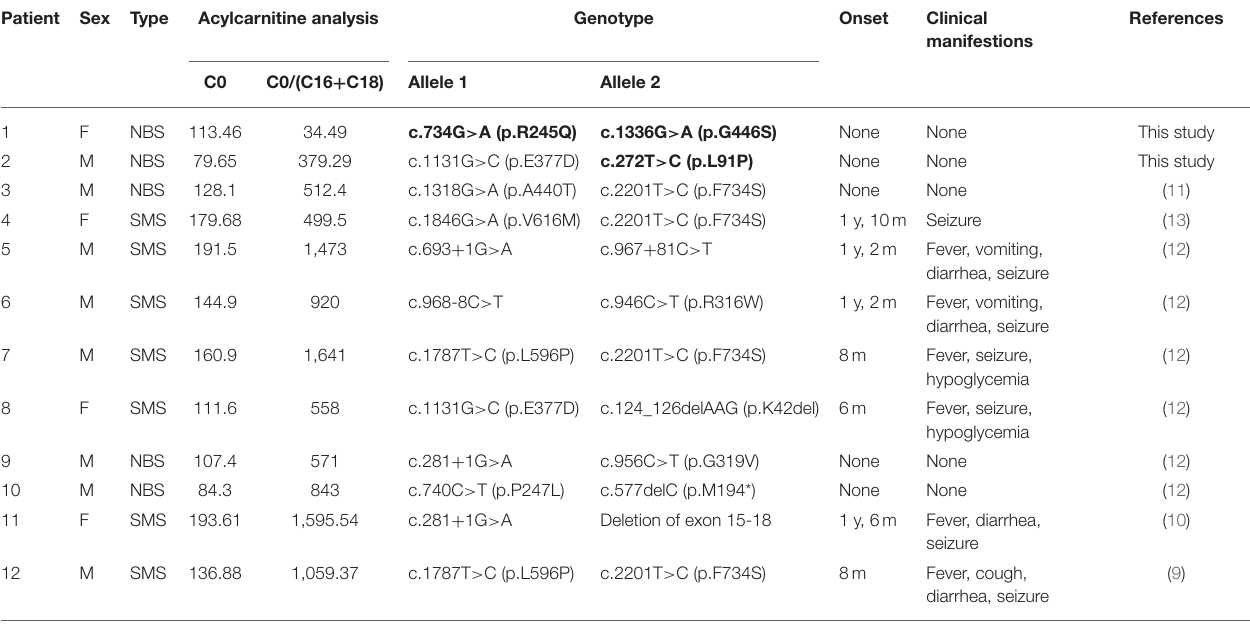
TABLE 1 | Biochemical, clinical, and molecular features of 11 Chinese patients with CPT1A